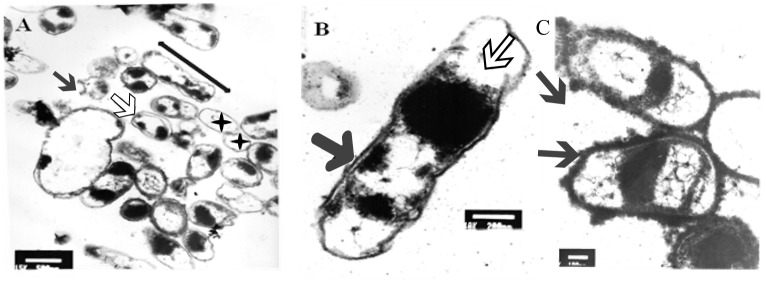
TEM micrograph of a full swarming area profile, after 5 min of exposure, in thin section (A) and at higher resolution (B). Electron microscopic images of P. aeruginosa swarmer cell with an excess of S-layer at the both ends of the bacterial cell (C). (A) Bars = 500 μm; (B) bars = 200 μm; (C) bars = 300 μm. The micrograph reveals extensive heterogeneity in terms of cell distribution and physiological status. Black star indicates ghost cells with empty envelope structure and damaged cells with condensed cytoplasmic material (black arrowheads) are visible. Double arrow shows cellular dilation in some cells after shorter exposure. Black arrow indicates membrane separation and white arrow indicates early disintegration. Arrows indicate S-layer.